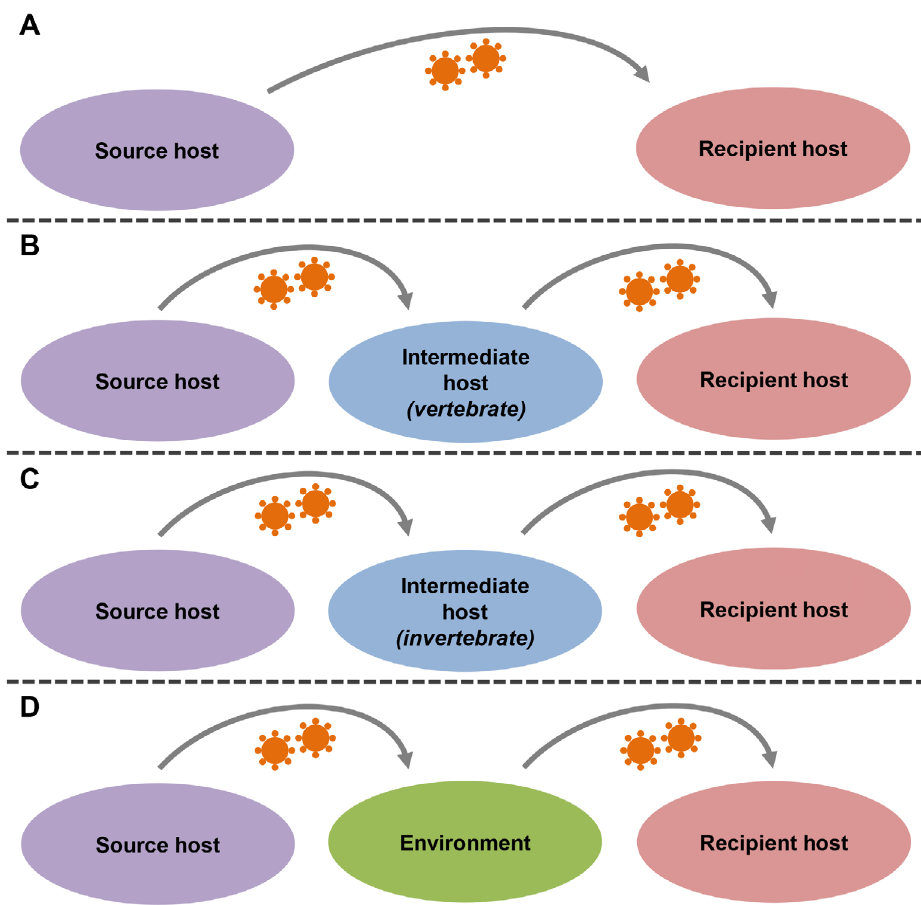
Figure 2 – Models of zoonotic spillover. Pathogens can overcome the barriers between species in different ways. A: the pathogen can be transmitted directly from the source host to the recipient host (e.g., a virus is transmitted from a bat to a human, via a bat bite). B: the pathogen can be transmitted from the source host to an intermediate vertebrate host and then be transmitted to the recipient host (e.g., a protozoan is transmitted from a wild species to a domestic dog, which then transmits the parasite to a human host). C: the pathogen can be transmitted from the source host to an intermediate invertebrate host and then be transmitted to the recipient host (e.g., an arbovirus is transmitted from a wild primate to a mosquito, which then transmits the virus to a human host). D: the pathogen can be transmitted from the source host to the environment and then be transmitted to the recipient